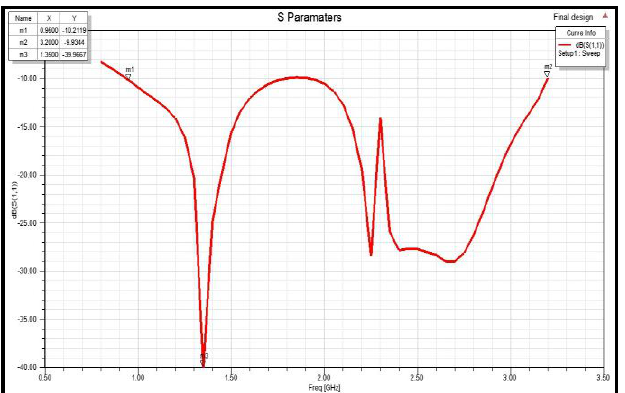
Figure 4: Simulated Return loss for dipole antenna.